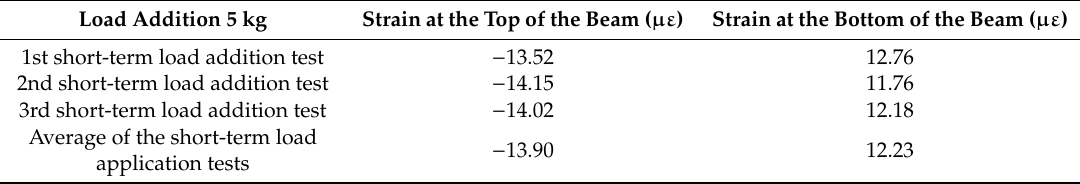
Table 2. The short-term load addition test for measuring the strain at the top and bottom of the